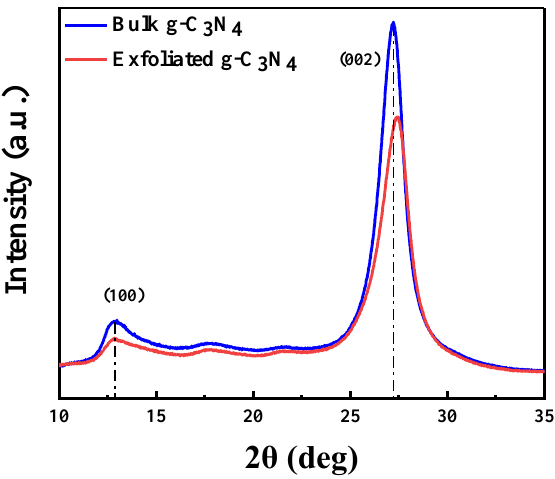
Figure 5. X-ray diffraction patterns of bulk and exfoliated g-C 3 N 4 .